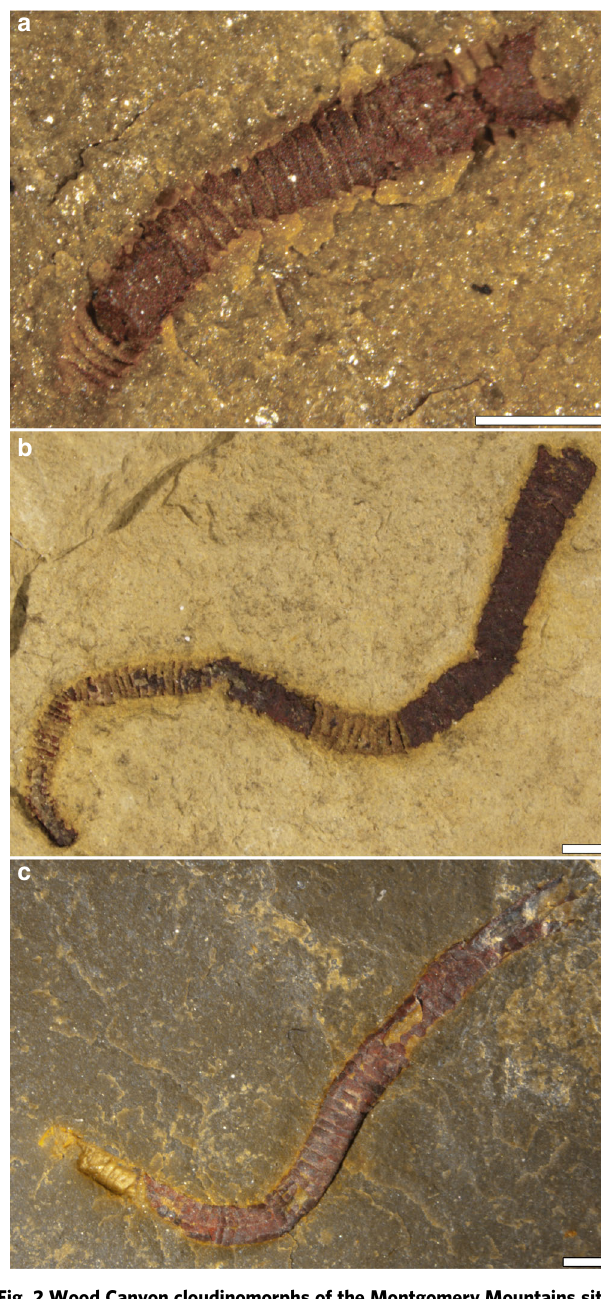
Fig. 2 Wood Canyon cloudinomorphs of the Montgomery Mountains site.